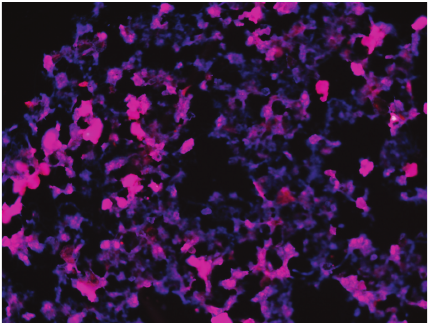
Figure 6: FISH image ( × 50) of Accumulibacter for oligonucleotide probes in the activated sludge samples from anoxic tank; Accu- mulibacter labeled with Cy3 is shown in pink combining red with blue, and all other bacteria are shown in blue generated by DAPI